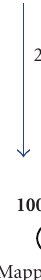
Figure 5: Branch and bound for fitting